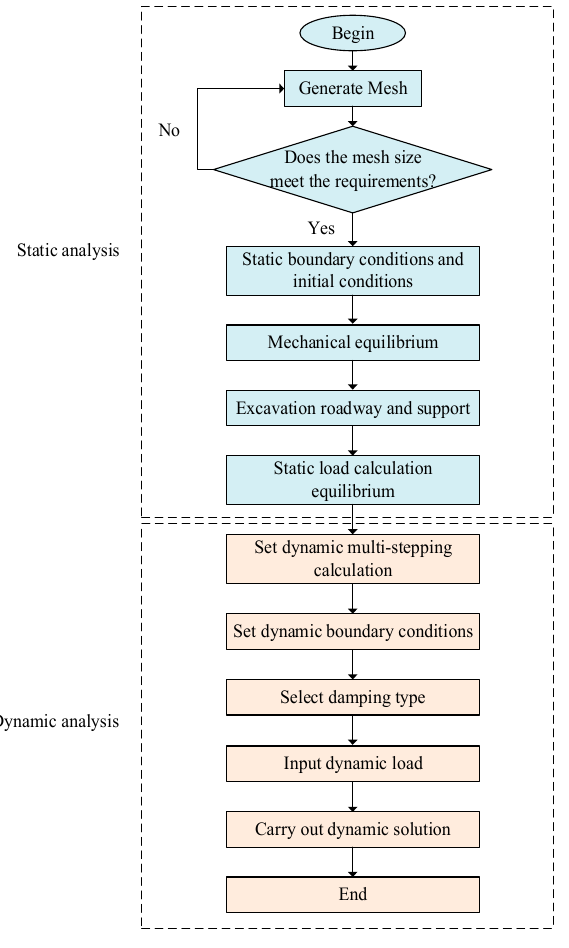
Figure 5. Calculation sequence used for the numerical model.